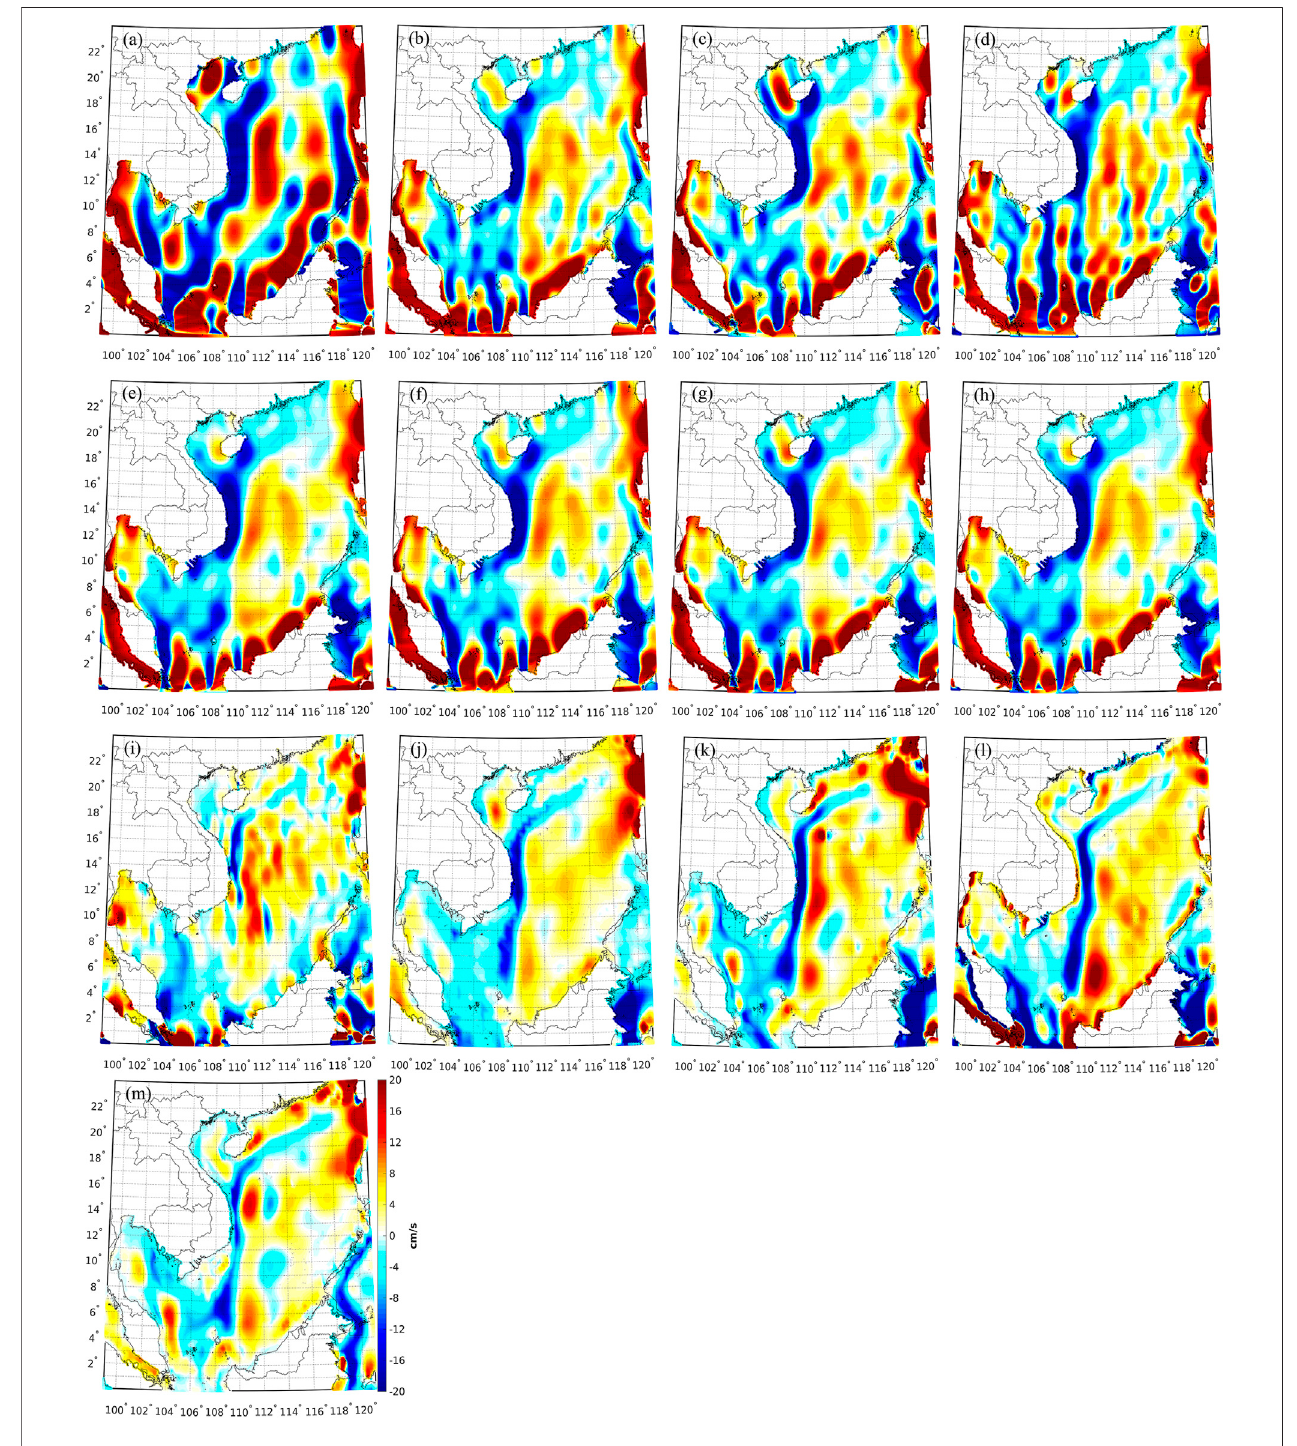
FIGURE 12 | Meridian geostrophic velocities computed from the MDT derived from (A) EGM2008, (B) GECO, (C) SGG-UGM-1, (D) EIGEN-6C4, (E) XGM2019_2159, (F) GOCO05c, (G) XGM2016, (H) XGM2019, (I) CNES-CLS13MDT; and meridian velocities retrieved from (J) SODA, (K) ORAS5, (L) OCCAM, and (M) AIPO.